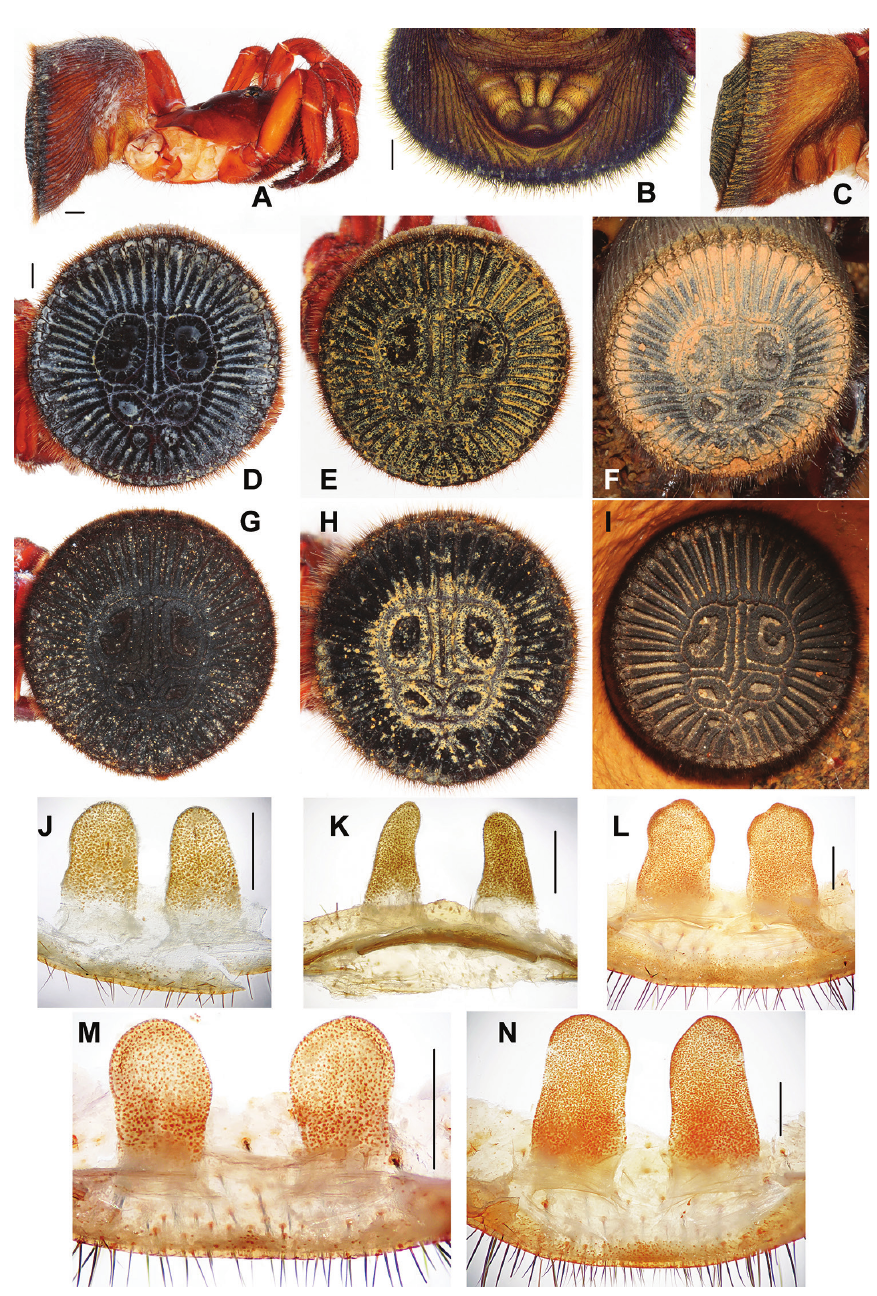
Figure 2. Cyclocosmia latusicosta Zhu, Zhang & Zhang, 2006 A habitus of female, lateral view (17-I-2013) B posterior portion of opisthosoma, ventral view, showing spinnerets C abdomen, lateral view (XUC- 2016-017) D–I abdomen, caudal view ( D 17-I-2013 E XUC-2016-017 F LH-2016-002 G LH-2016-003 H LH-2016-004 I LH-2016-005) J–N female genitalia ( J 17-I-2013 K XUC-2016-017 L LH-2016-003 M LH-2016-004 N LH-2016-005), dorsal view. Scale bars A, B, D 1mm, J–N 0.5